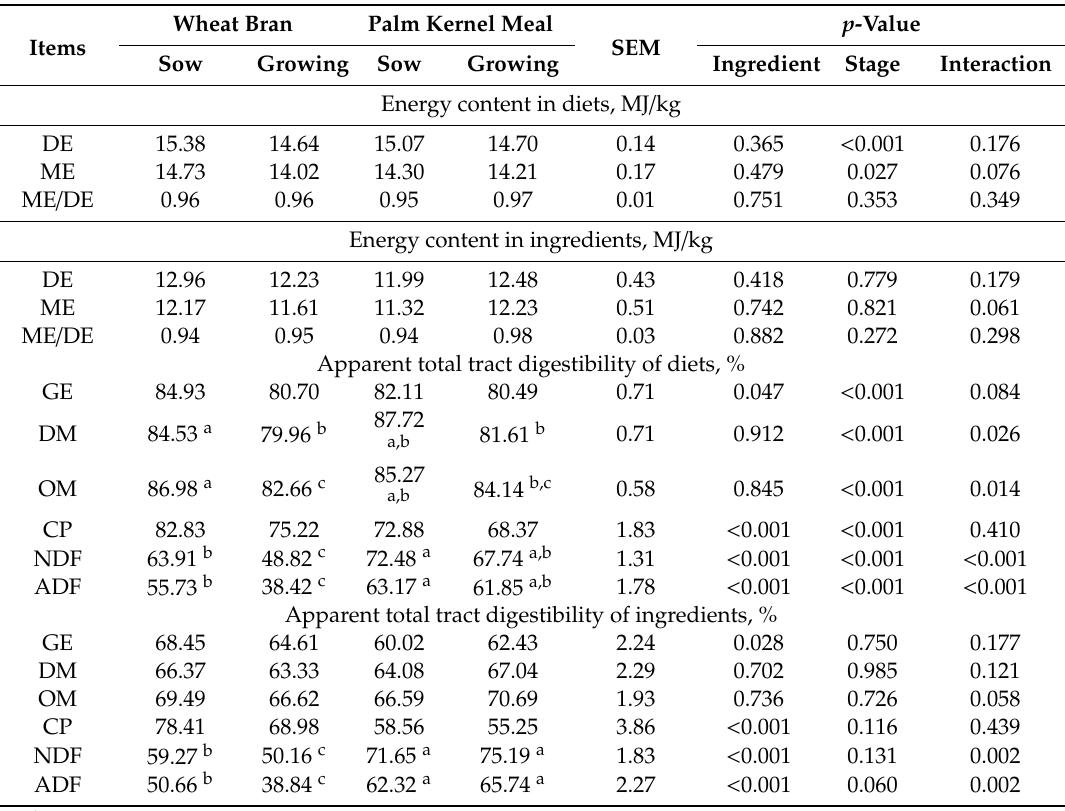
Table 6. Comparative energy and nutrient utilization in low protein high fiber (LPHF) diets and ingredients by adult sows and growing pigs 1 (dry matter